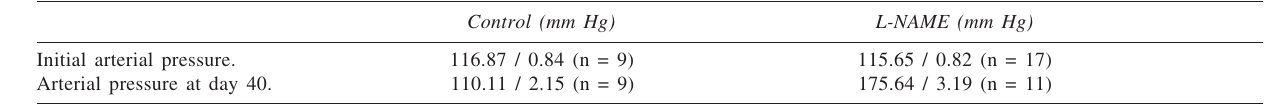
Table 1 - Tail-cuff arterial pressure measured during the experiments (mean / standard error).